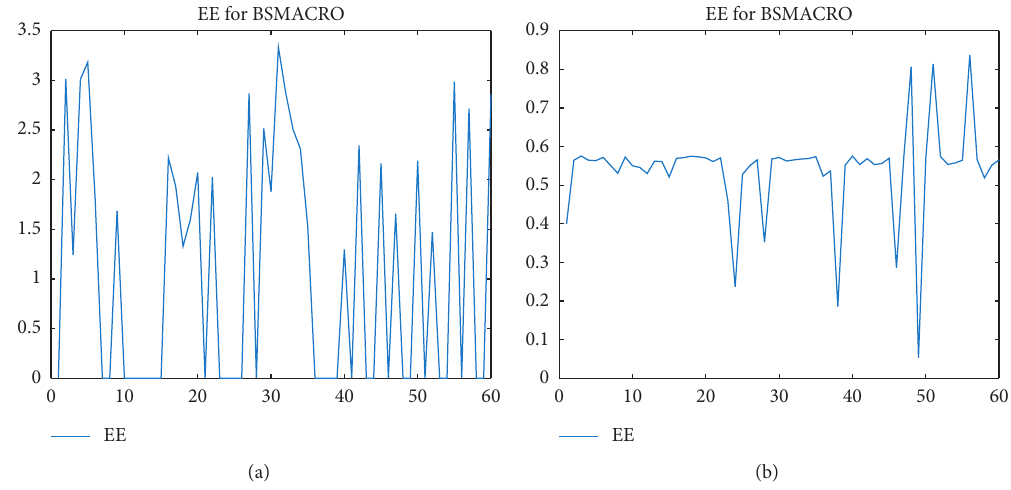
Figure 5: The energy efficiency (a) and SINR (b) of macro BS for 60 MUE.